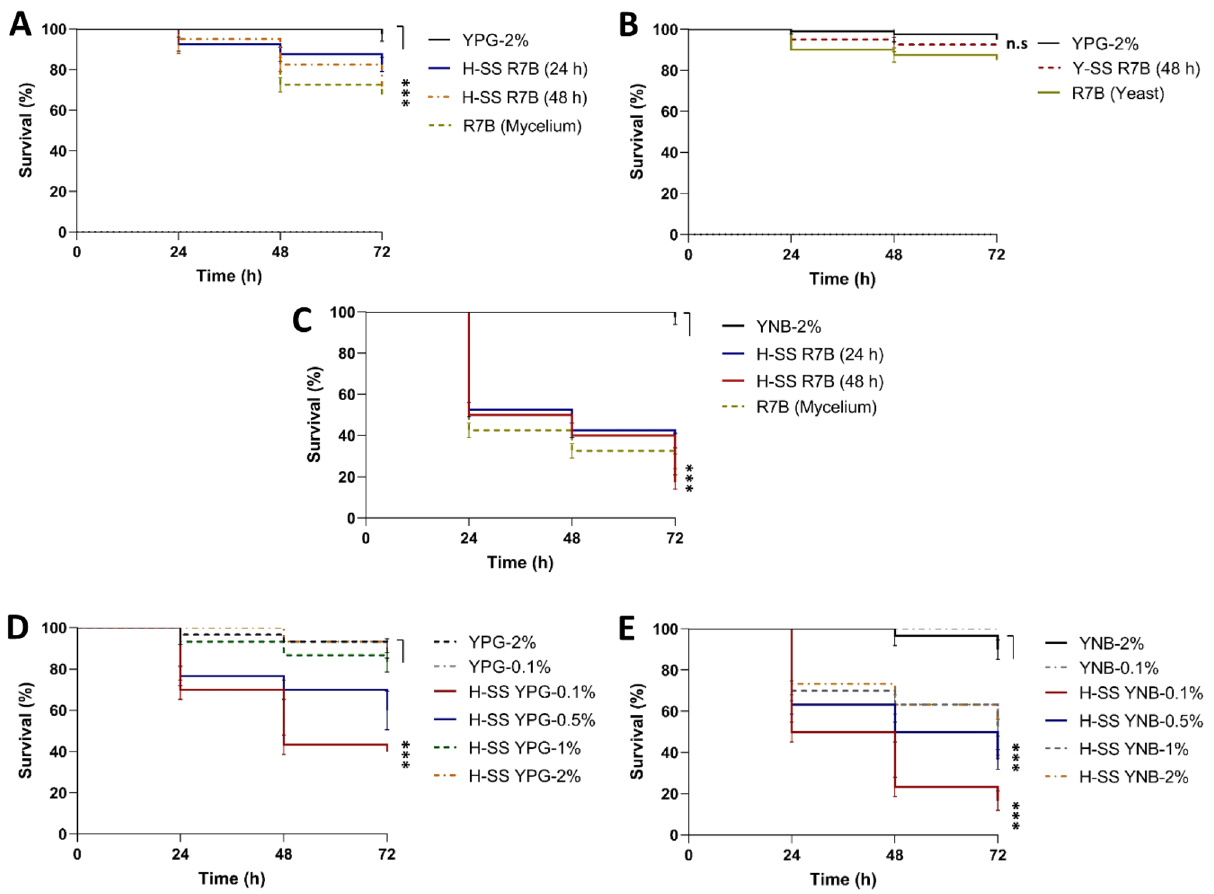
Figure 1. Analysis of the toxicity of the cell-free supernatant of the culture broth (SS) of M. lusitanicus under different growth conditions. Quantification of the toxicity of the SS obtained from the wild-type strain R7B grown in YPG medium with 2% glucose (YPG-2%) after ( A ) aerobic growth (H-SS) or ( B ) anaerobic growth (Y-SS) at indicated times against Caenorhabditis elegans ; hyphae and yeast cells obtained from 3 and 8 h, respectively, were recovered under the corresponding growth conditions and tested against the nematode. ( C ) Hyphae from a culture with 3 h of growth or its SS obtained from the YNB medium with 2% glucose (YNB- 2%) after aerobic growth at indicated times were used to treat the nematode. Quantification of the toxicity of the SS obtained after aerobic growth for 48 h in ( D ) YPG medium and ( E ) YNB medium supplemented with different concentrations glucose (0.1, 0.5, 1, and 2%). A total of 15–20 nematodes were used per experiment and incubated at 18 °C for 72 h. The results presented are the average values obtained from four independent experiments. Data were statistically analyzed using the Mantel-Cox test. *** P < 0.01. When results were not considered significant, we did not provide an additional indication ( P >